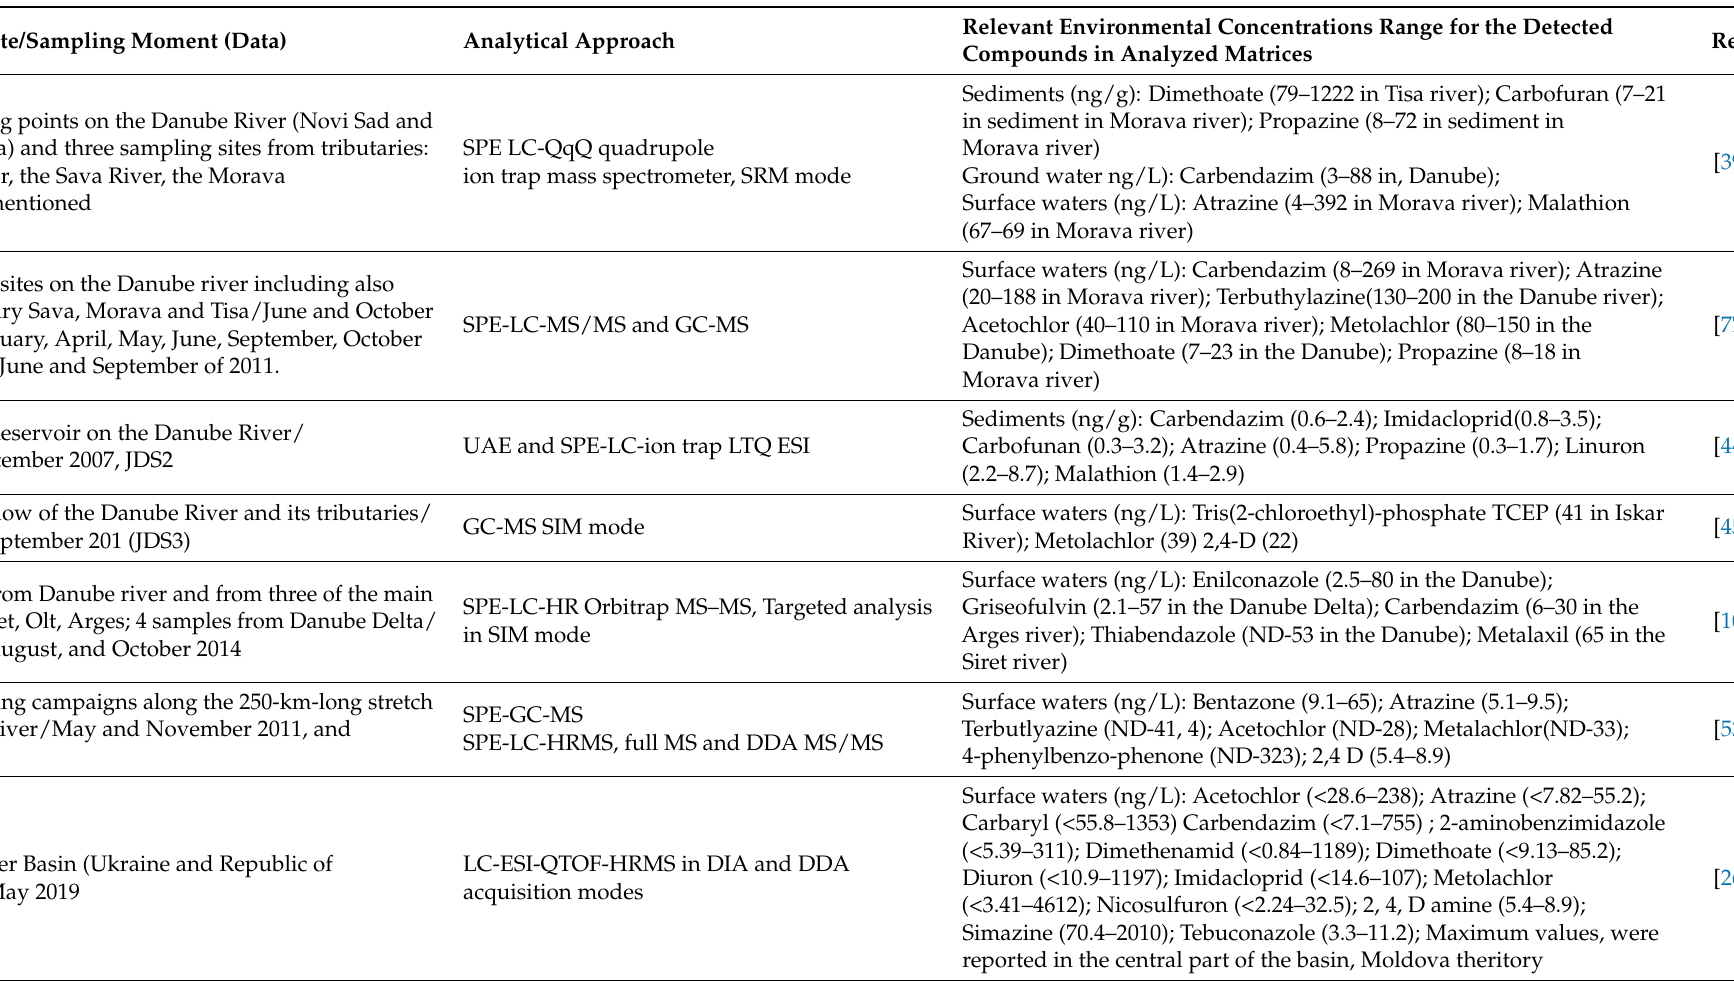
Table 3. Summary of the publication during 2010–2021 on the area of Low Danube and Nord-West Black Sea Basins concerning pesticides (other than